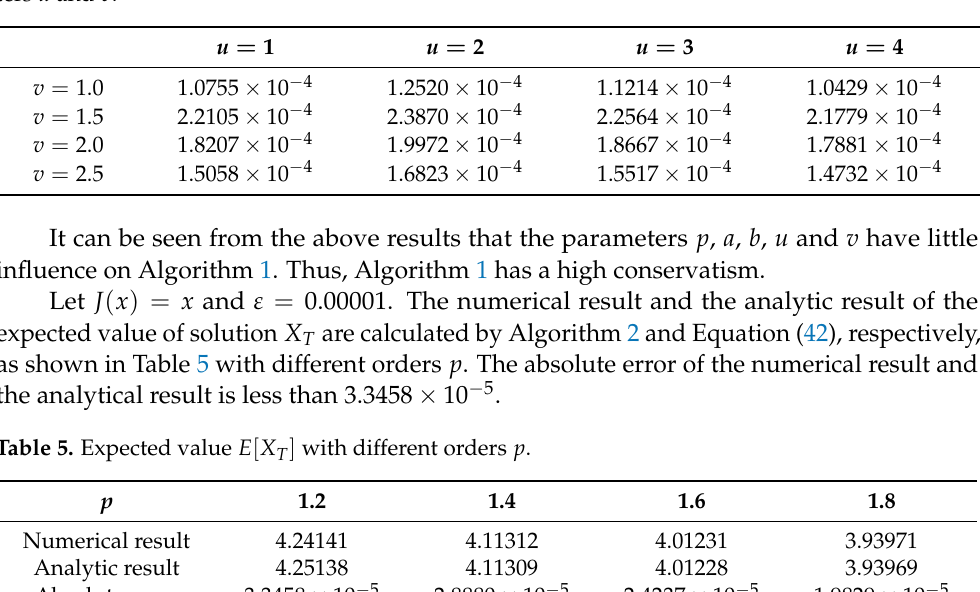
Table 4. The maximum absolute error of the analytic and numerical solutions with different parame- ters u and v .